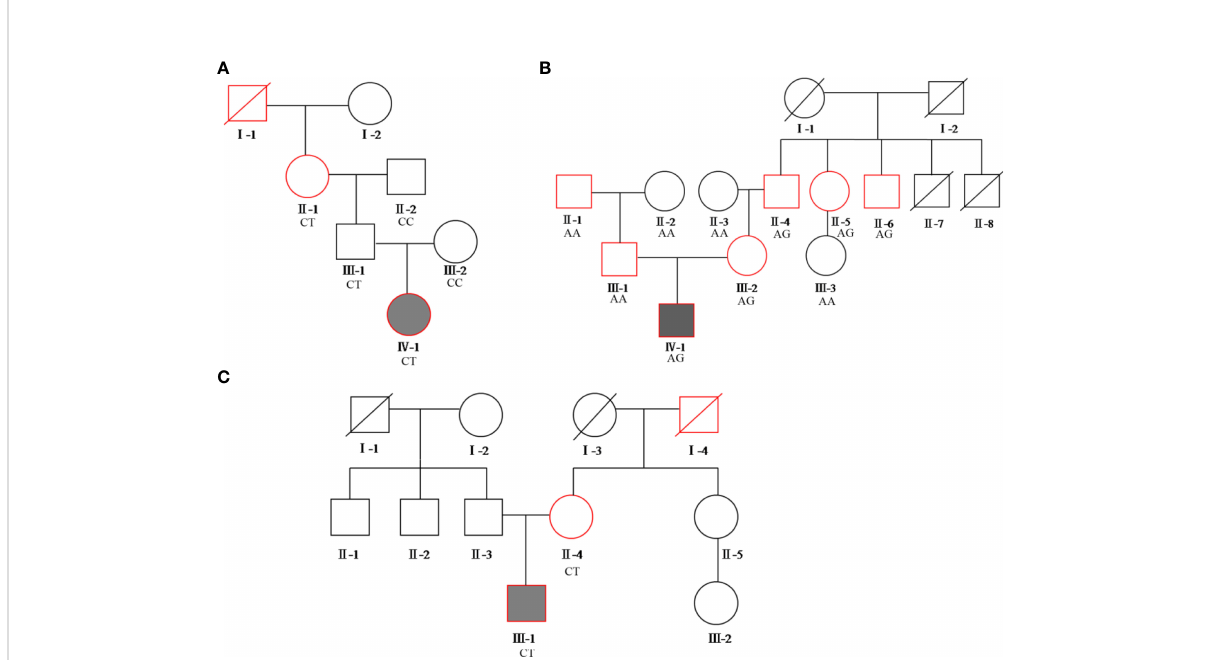
FIGURE 1 Pedigree of the three families. Squares represent males, while circles represent females. The red border represents diabetes, the blackened box represents the proband. (A) proband A ’ s family pedigree; (B) proband B ’ s family pedigree; (C) proband C ’ s family pedigree. The genotypes of each variation of c.1555 C>T, c.3706 A>G, and c.2885 C>T in the ABCC8 gene are shown in families (A – C) ,